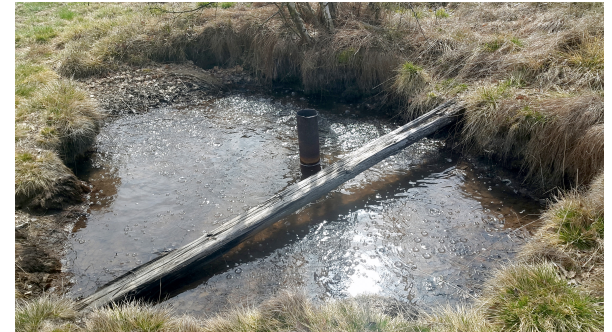
Figure 2. The major wet mofette in Hartoušov is located in the direct vicinity of the drill site. At the upper and lower part of the mofette bubbles of CO 2 -rich gas are